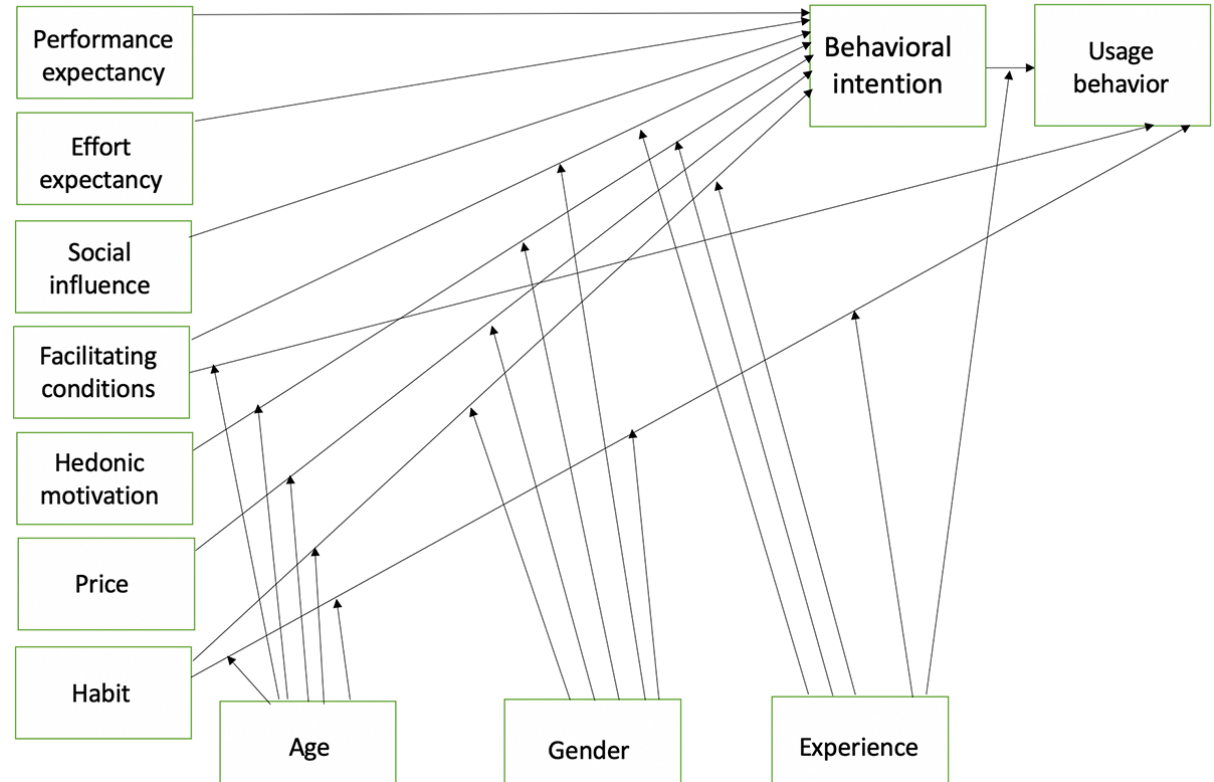
Figure 4. The Unified Theory of Acceptance and Use of Technology